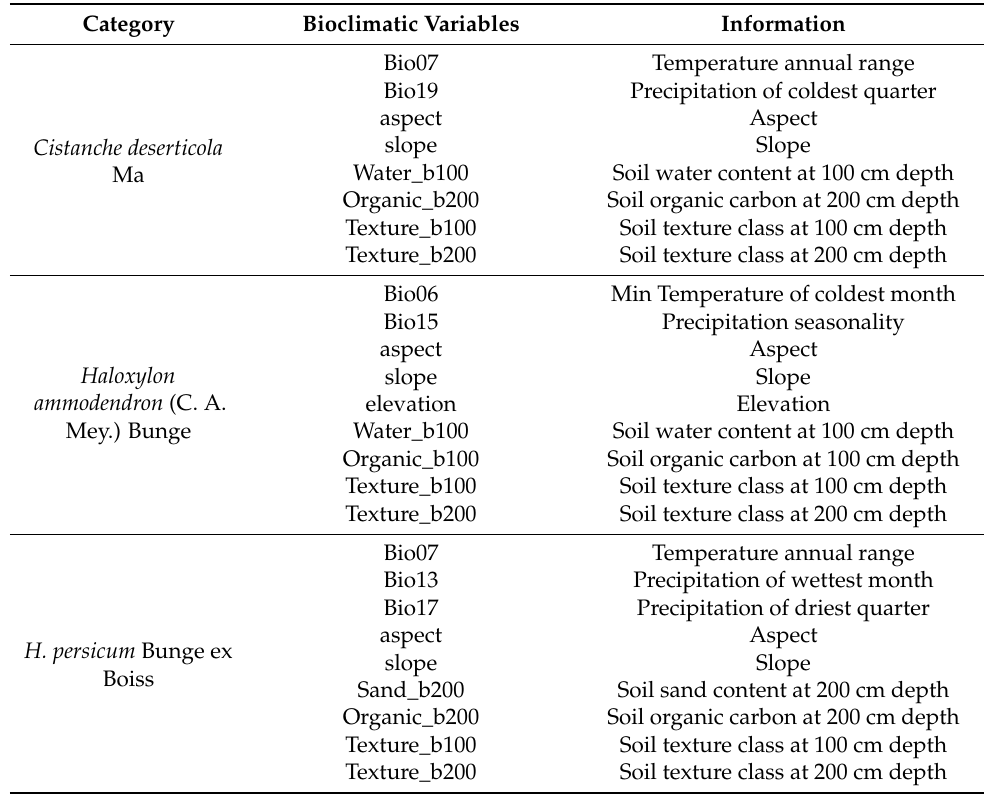
Table 1. The remaining environmental variables of each